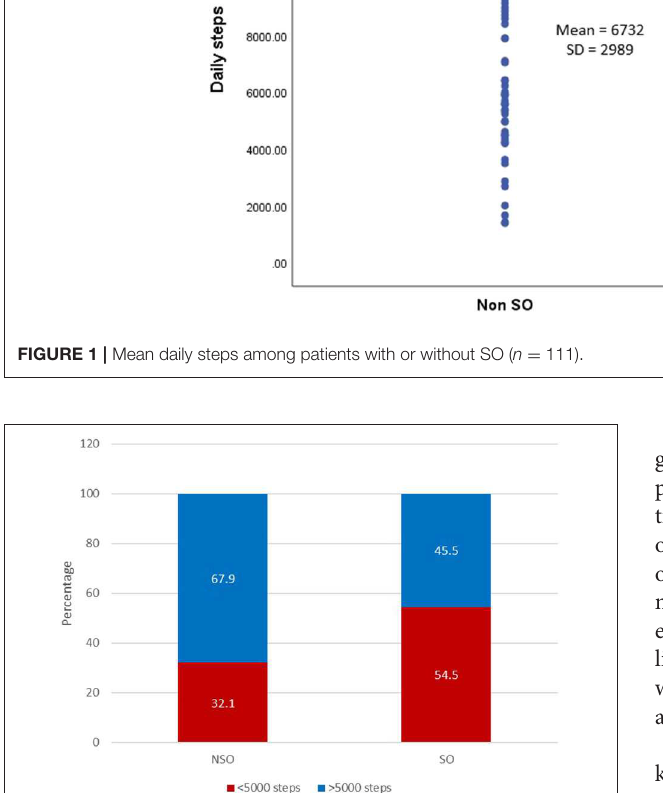
FIGURE 2 | Proportion of patients with SO considered inactive, performing less than 5,000 steps daily ( n =